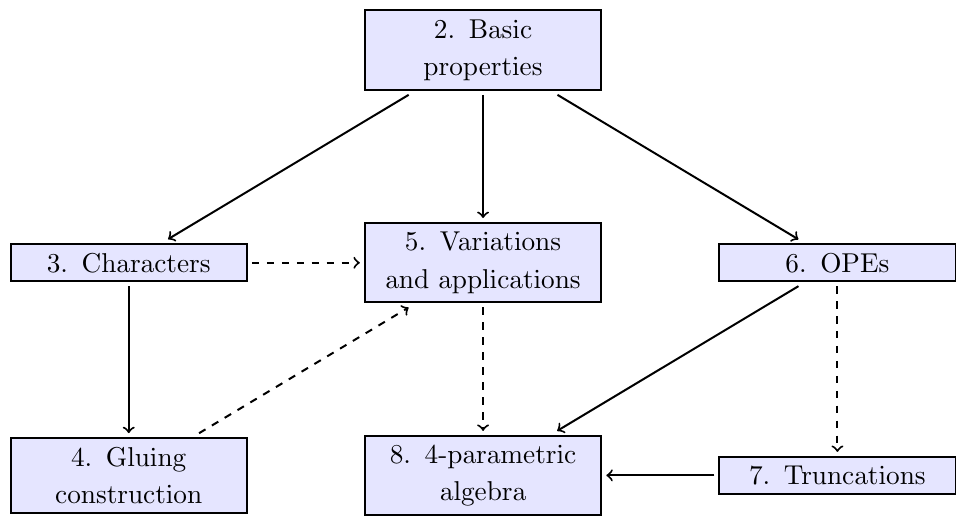
Figure 1 . The basic organization of the paper. Arrows indicate strong logical dependencies and we recommend to read the relevant sections